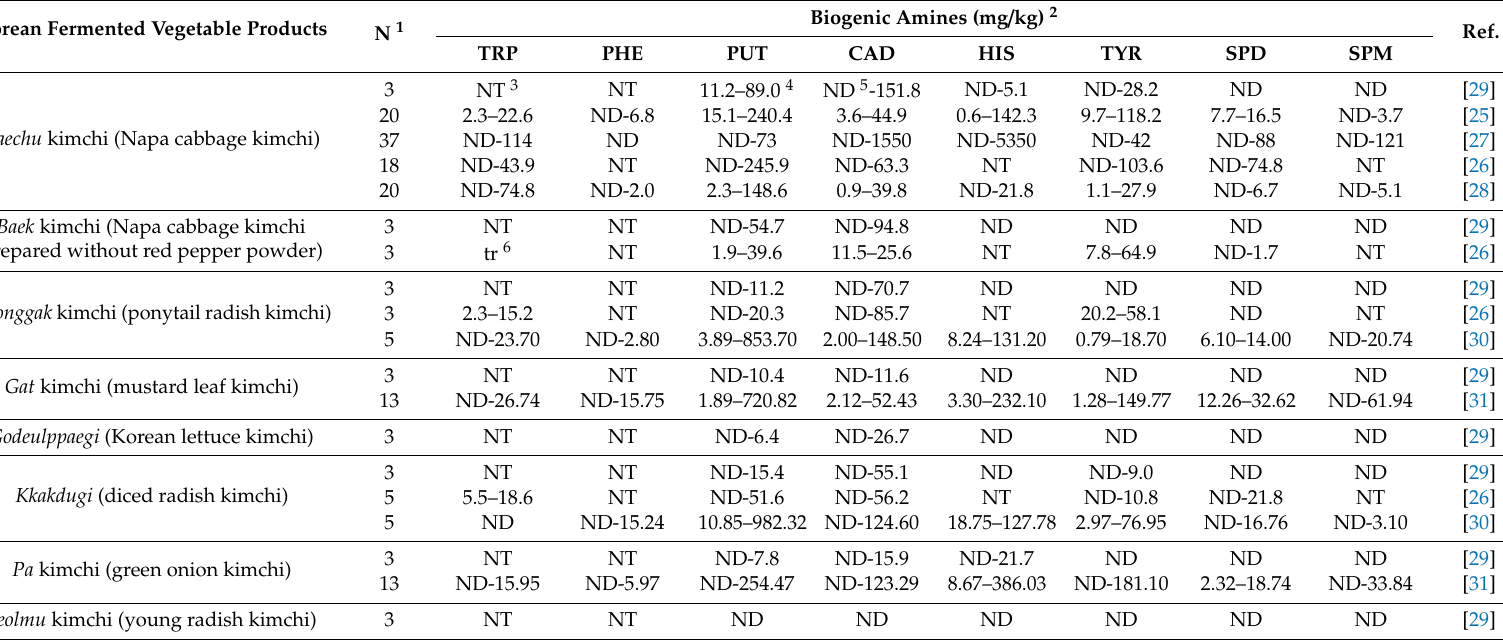
Table 1. Biogenic amine content of Korean fermented vegetable